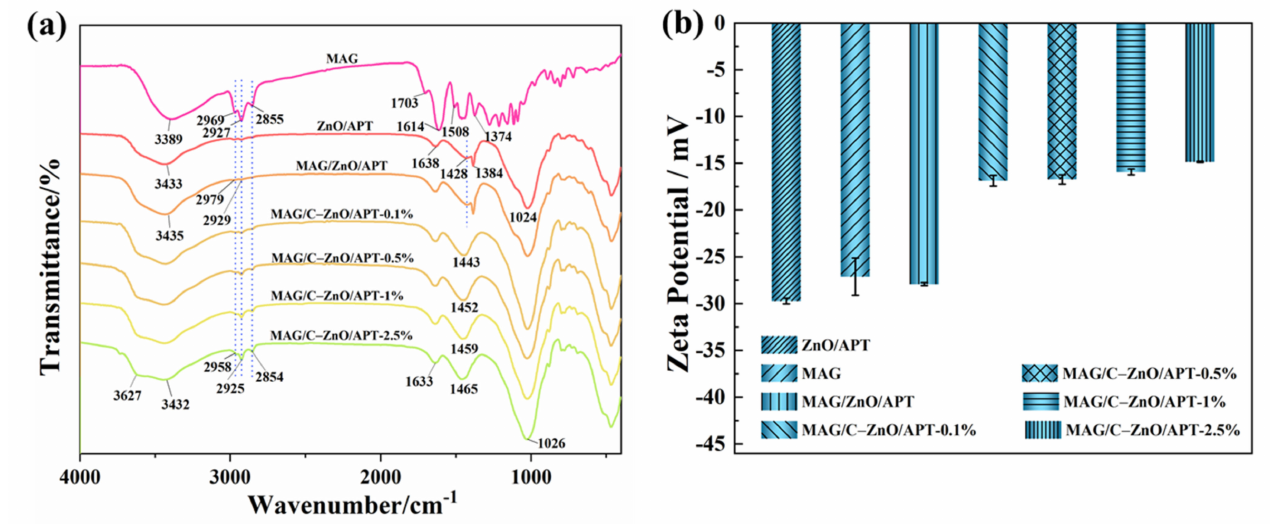
Figure 3. FTIR spectra ( a ) and zeta potential ( b ) of MAG, ZnO/APT, MAG/ZnO/APT and MAG/C– ZnO/APT